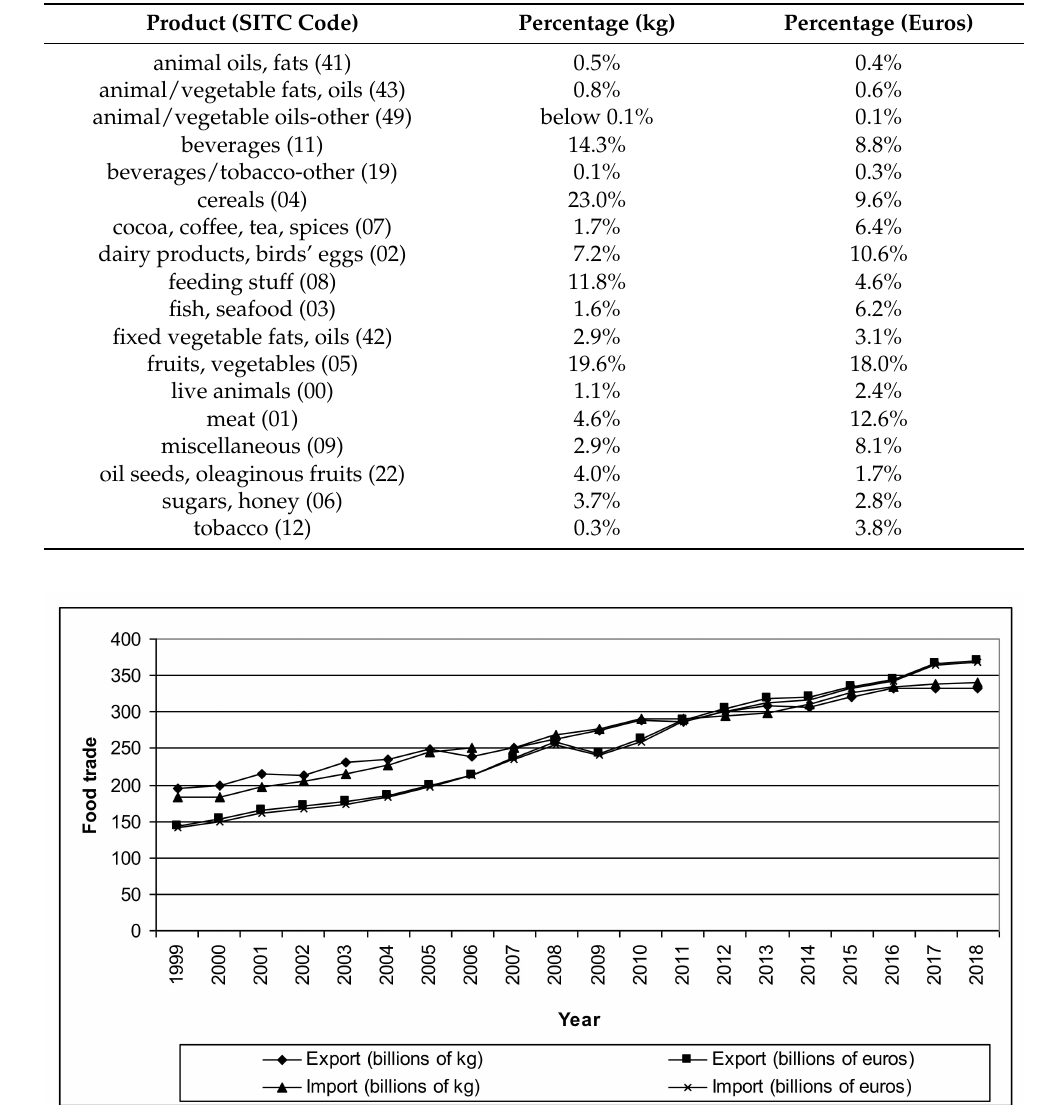
Table 2. Intra-EU food trade in 1999–2018 for particular products according to the Eurostat (SITC).